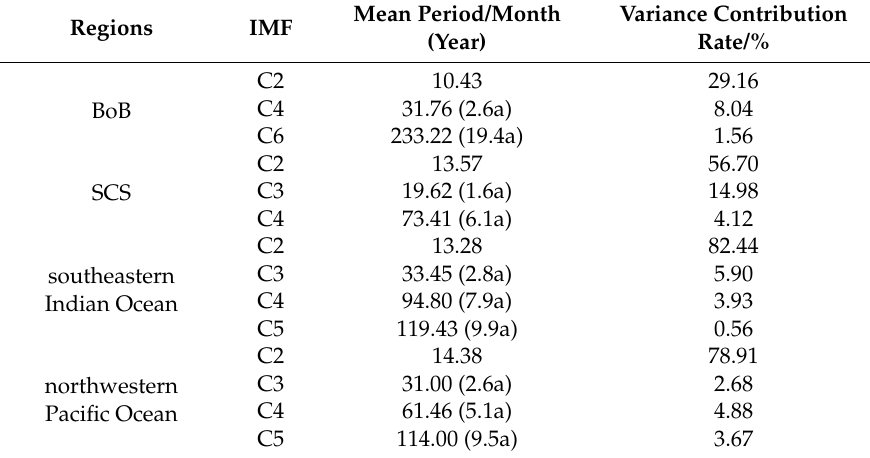
Table 3. The mean periods and variance contribution rates of the significant IMFs for domain-averaged NPP in the BoB, SCS, southeastern Indian Ocean, and northwestern Pacific